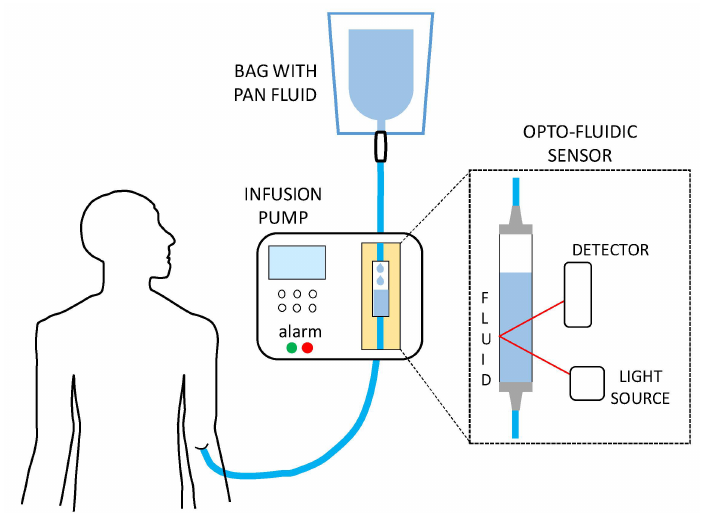
Figure 1. Schematic representation of the smart opto-fluidic sensor for recognition of PAN fluids and integration in commercial infusion